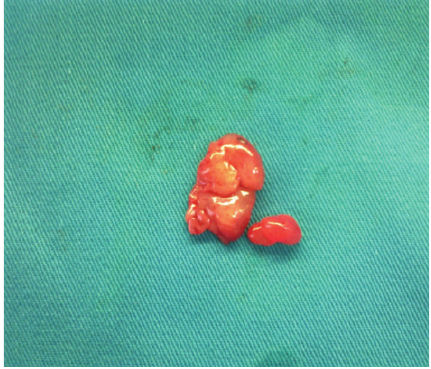
Figure 1: Decidual structures.